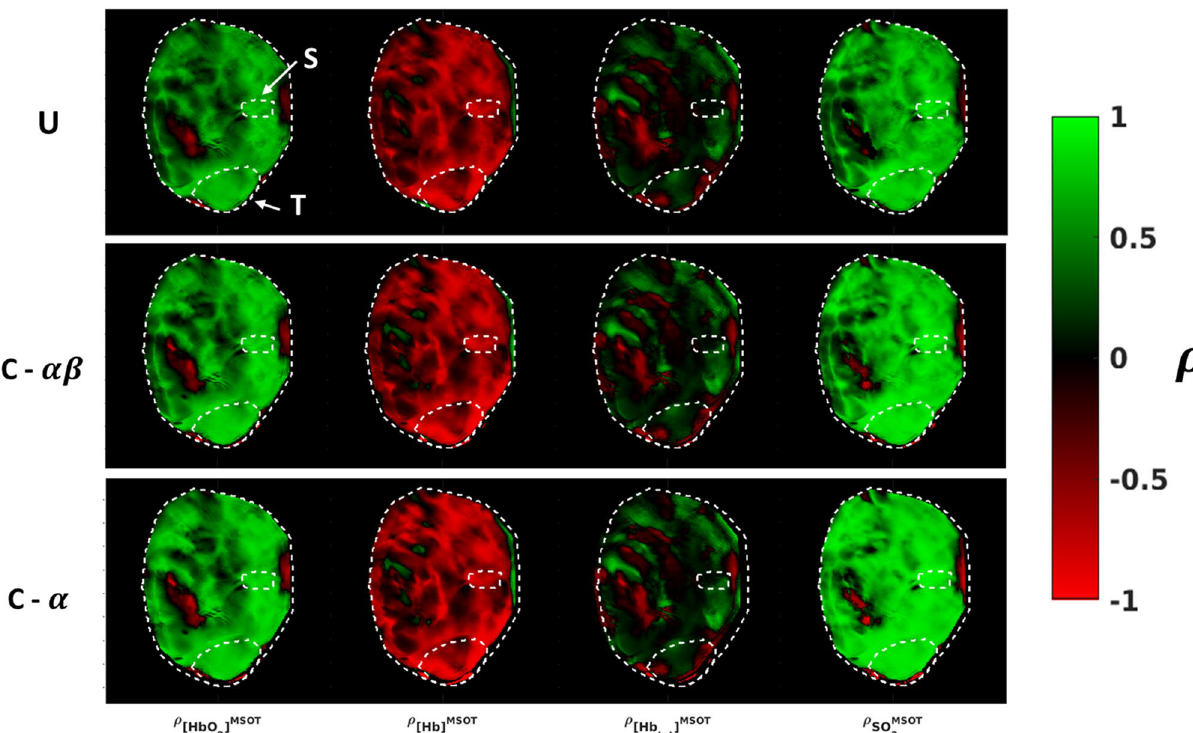
Figure 11. Correlation images against known inhaled O 2 time course for Dataset B. U: Unconstrained analysis. C- αβ : Constrained analysis using αβ Kalata filter. C- α : Constrained analysis using α Kalata filter. The use